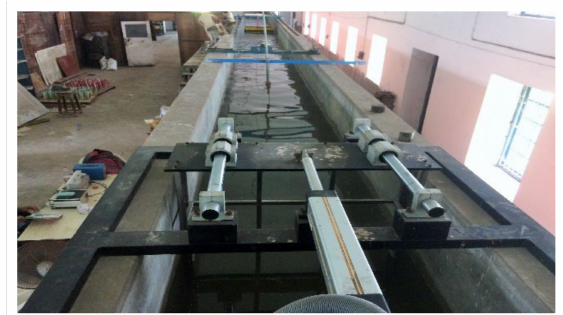
Figure 5. Wave flume and wave generator